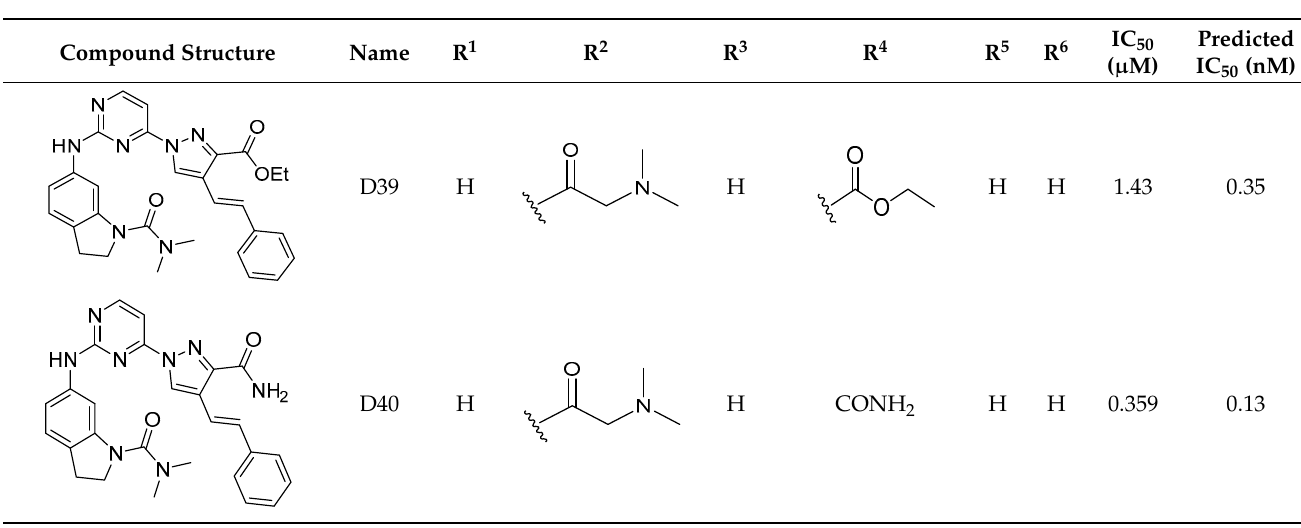
Table 3. The comparison of the actual and calculated IC 50 values of two synthesized PLK1 inhibitors.